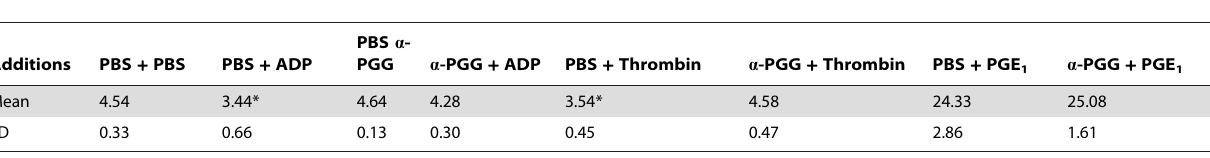
Table 1. a -PGG inhibited ADP- or thrombin-induced lowering of cyclic AMP.